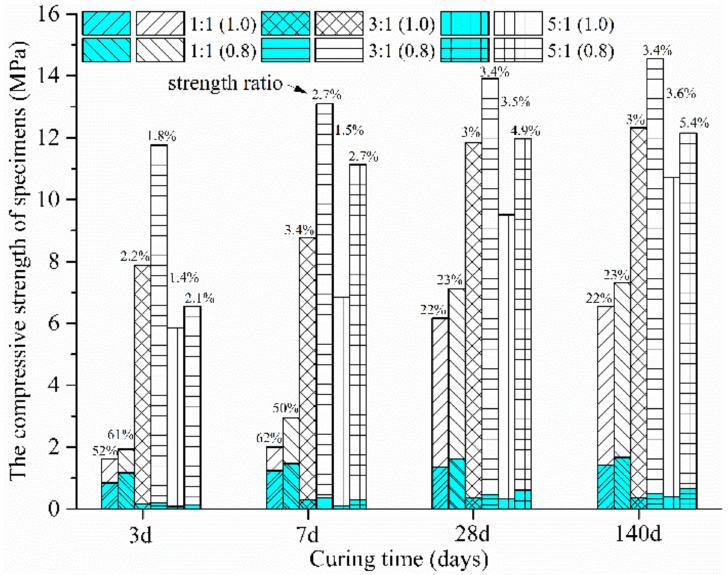
Figure 7. Compressive strength characteristics of CSG consolidation formed in water and